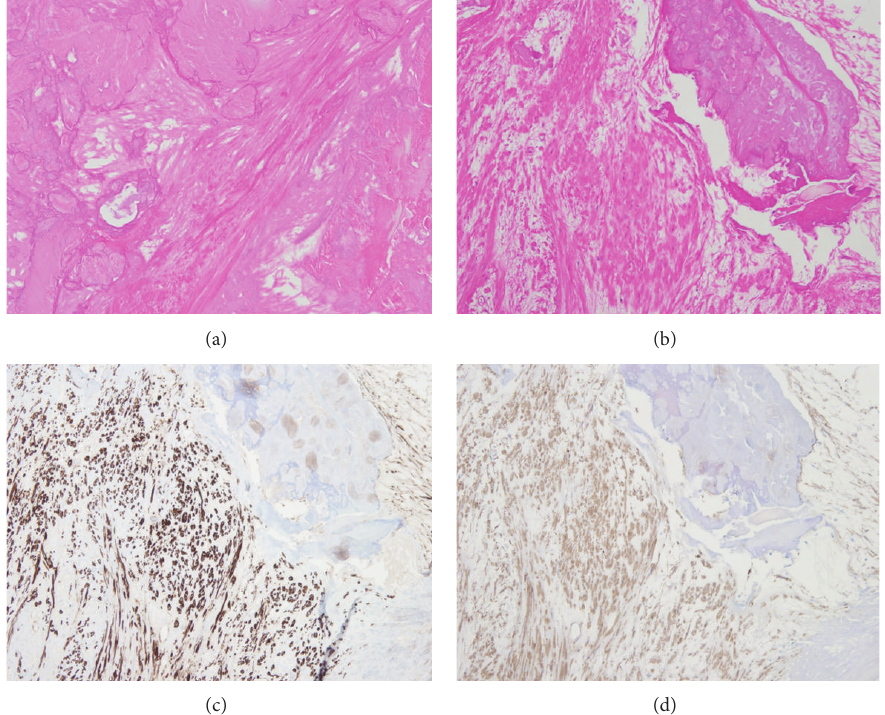
Figure4:Calcificationandsmoothmusclecells((a)-(b),HEstain × 200)((c)-(d),immunohistochemicalstain((c): 𝛼 -SMA;(d):h-caldesmon) × 200). The cells were proliferating in a tangled and crossed arrangement around calcification and stained intensely with 𝛼 -SMA and h-